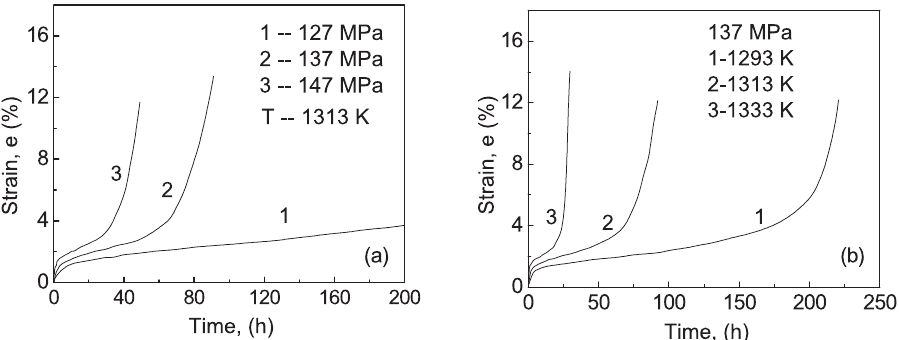
Fig. 2: Creep curves of alloy under different conditions. (a) Applied different stresses at 1313 K, (b) applied different temperatures at 137